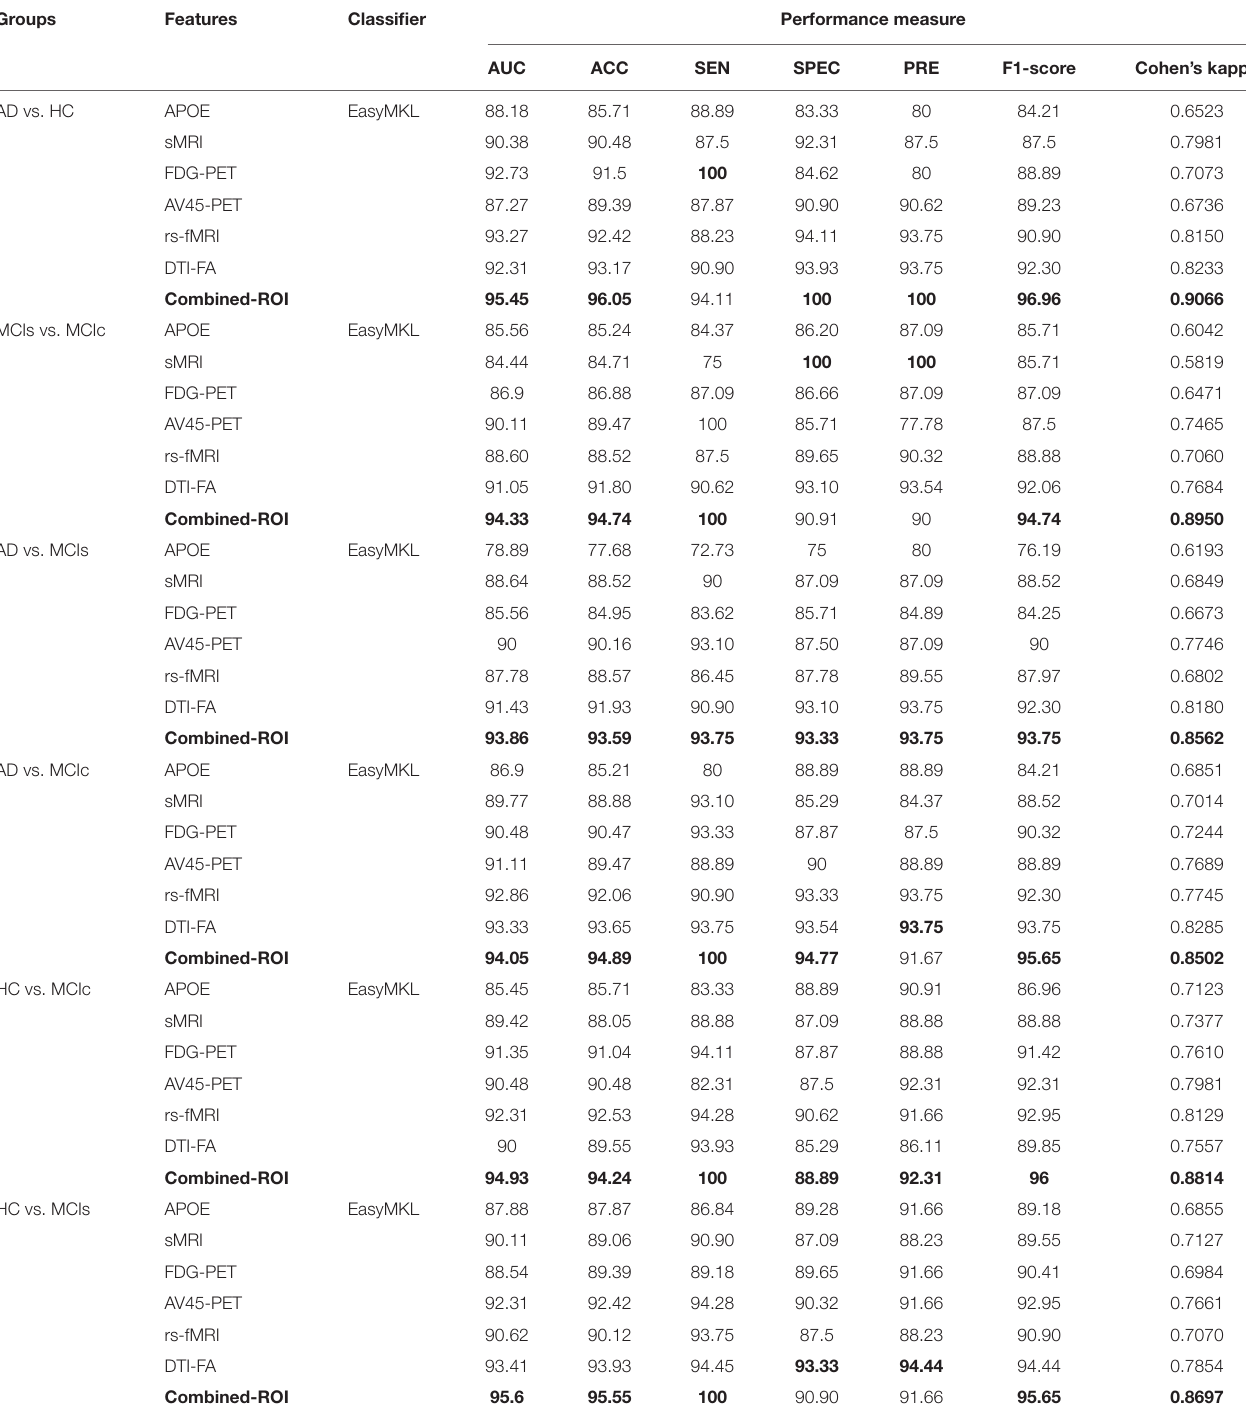
TABLE 2 | Classification results for AD vs. HC, MCIs vs. MCIc, AD vs. MCIs, AD vs. MCIc, HC vs. MCIc, and HC vs. MCIs groups using ROI features (EasyMKL).